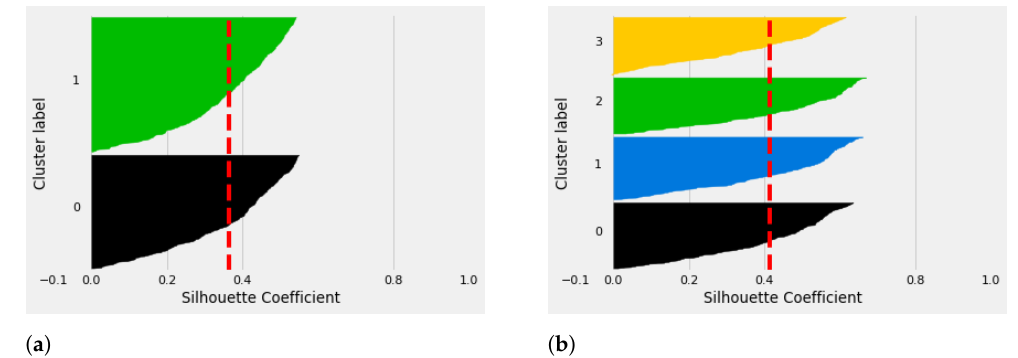
Figure 7. Silhouette Plot for n = 800 SMs: analyze the membership for each SM assigned to its corresponding cluster: ( a ) Cluster label vs. silhouette index, for K = 2; ( b ) Cluster label vs. silhouette index, for K =